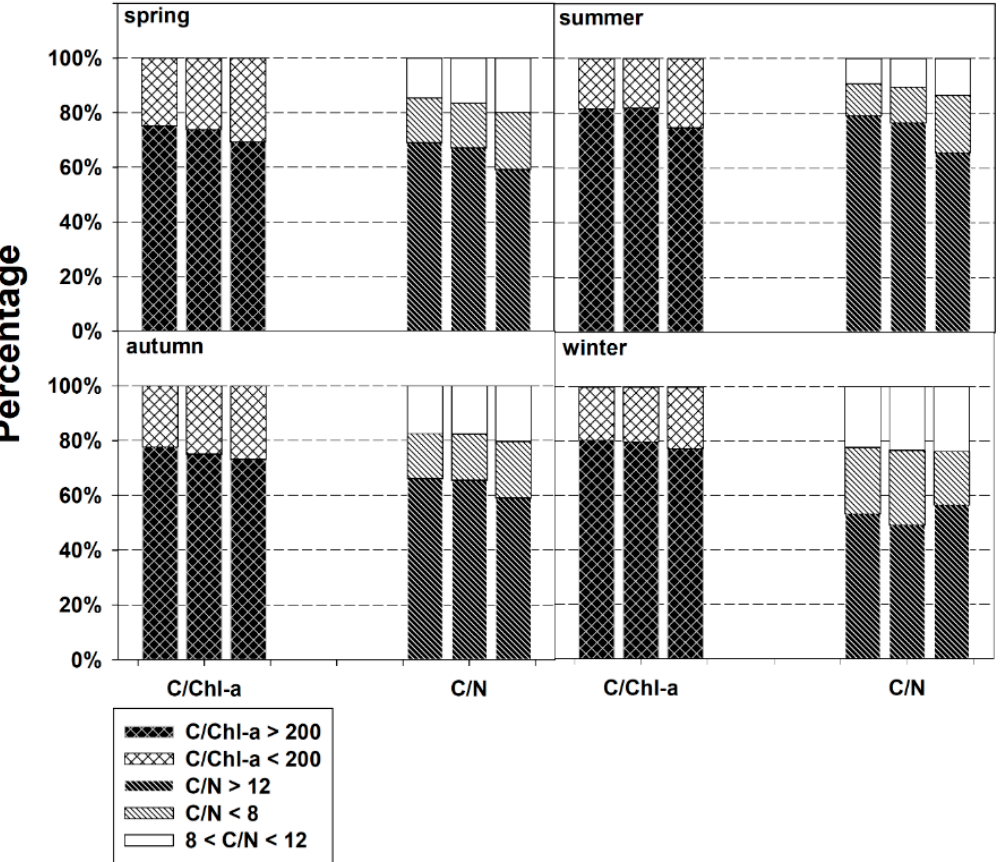
Figure 11. Percentages of areas with C/Chl -a > 200 and C/Chl -a < 200 and percentages of areas with C/N > 12, C/N < 8, and 8 < C/N < 12 in the coastal region of the ECS and Changjiang Estuary in different seasons. The areas with C/Chl -a > 200 and C/Chl -a < 200 are dominated by the non-living organic pool and living biological part, respectively; the area with C/N > 12 indicates a terrestrial source, while areas with C/N < 8 and 8 < C/N < 12 represent oceanic and uncertain sources, respectively. From left to right, each group represents the ES-TGP, MS-TGP, and LS-TGP, respectively.